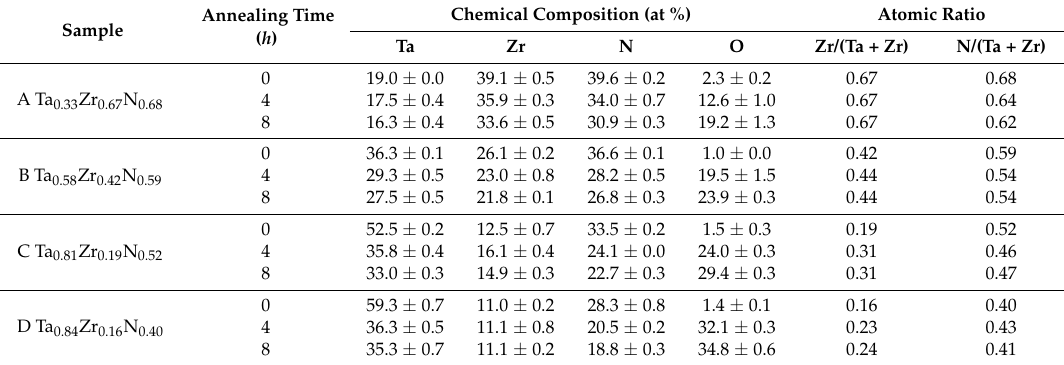
Table 2. Chemical compositions of as-deposited and 600 ◦ C-annealed Ta–Zr–N thin films. Chemical Composition (at Annealing Time Sample ( h )